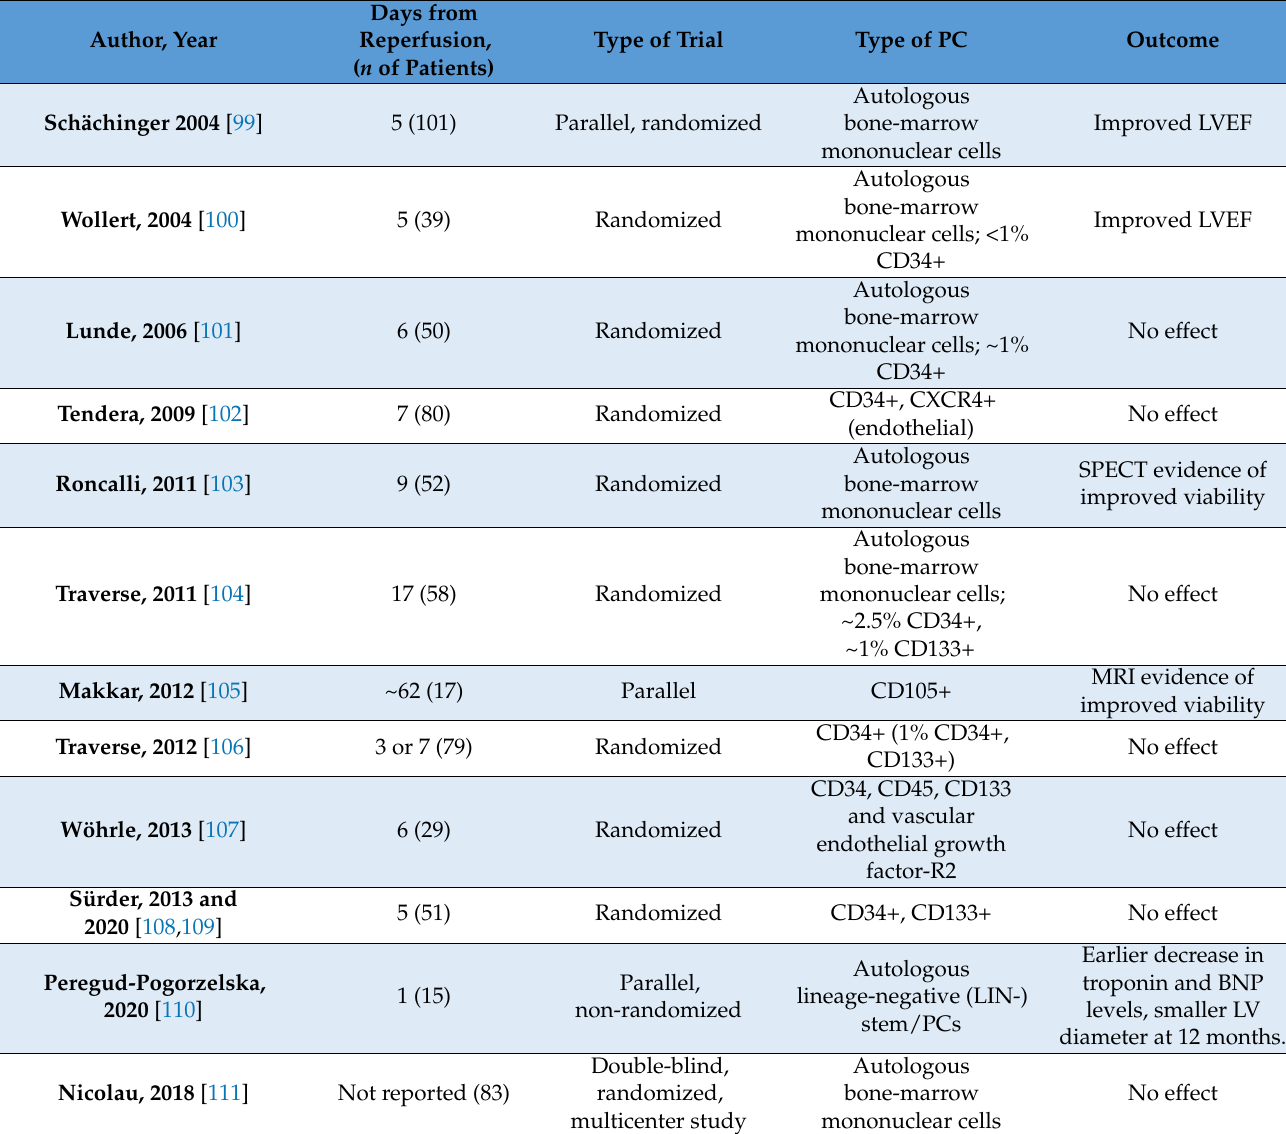
Table 1. Studies of PC therapy early after stenting for